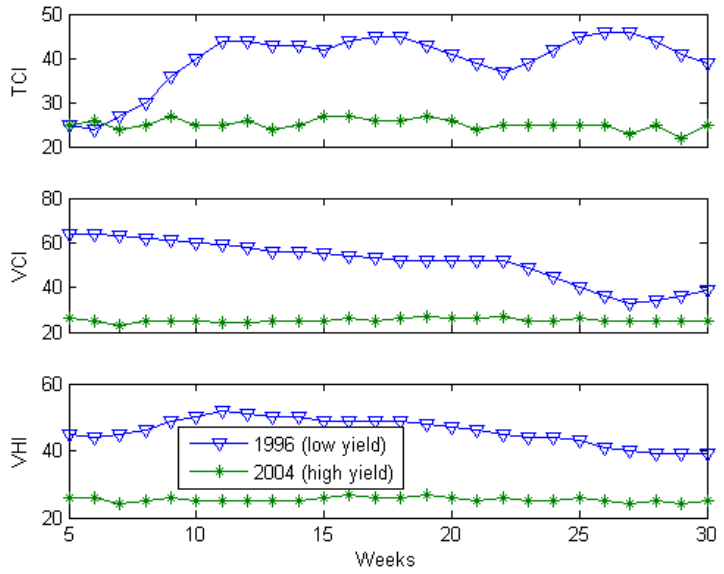
Figure 3. TCI, VCI and VHI for the years with the smallest and largest aus rice